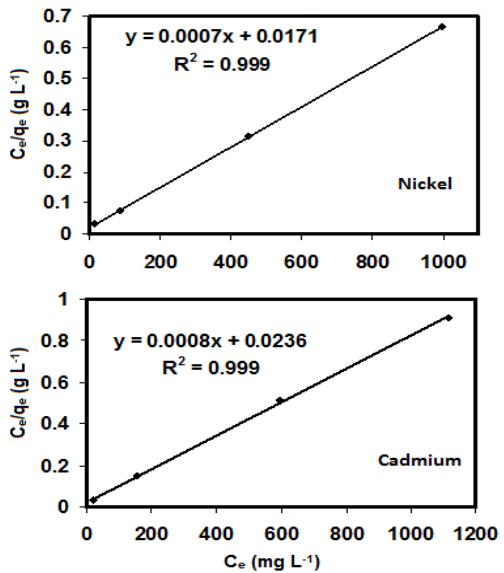
Fig. 7. Liner Langmuir isotherm of cadmium and nickel removal by PPI dendrimer (pH=7, adsorbent=0.08 g/L, T=298